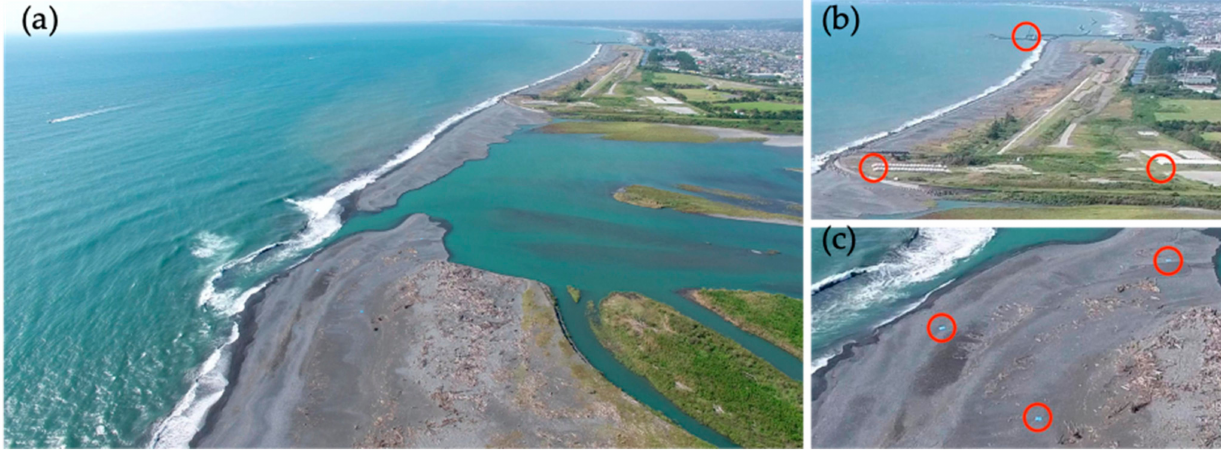
Figure 3. An example frame of the video and ground control points (GCPs) indicated by red circles (Case 4): ( a ) a video frame by UAV and ( b , c ) enlarged views of ground control